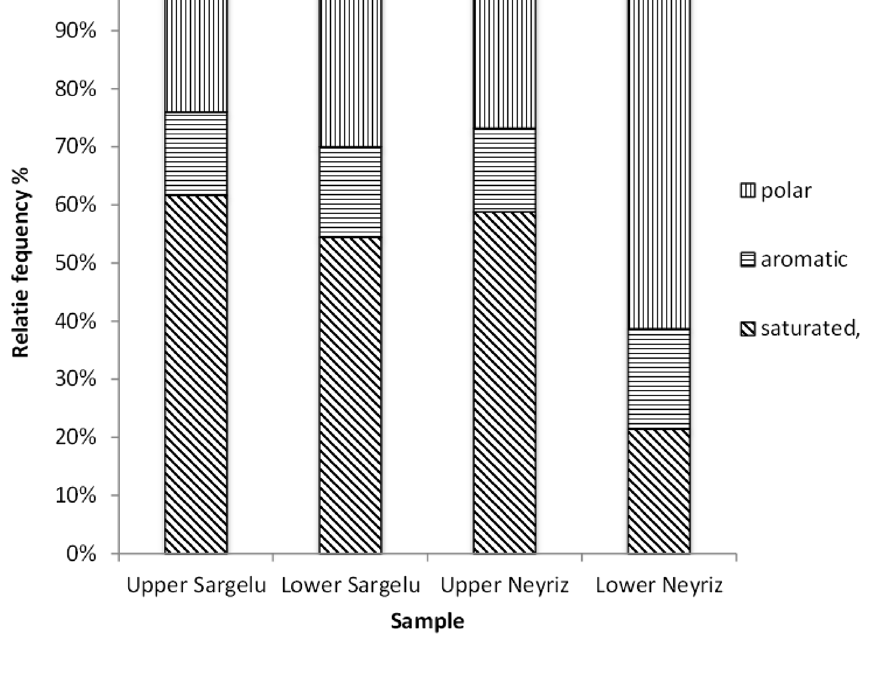
Fig. 6 Ternary diagram of bulk composition of extract com- ponent (ternary diagram from Tissot and Welte